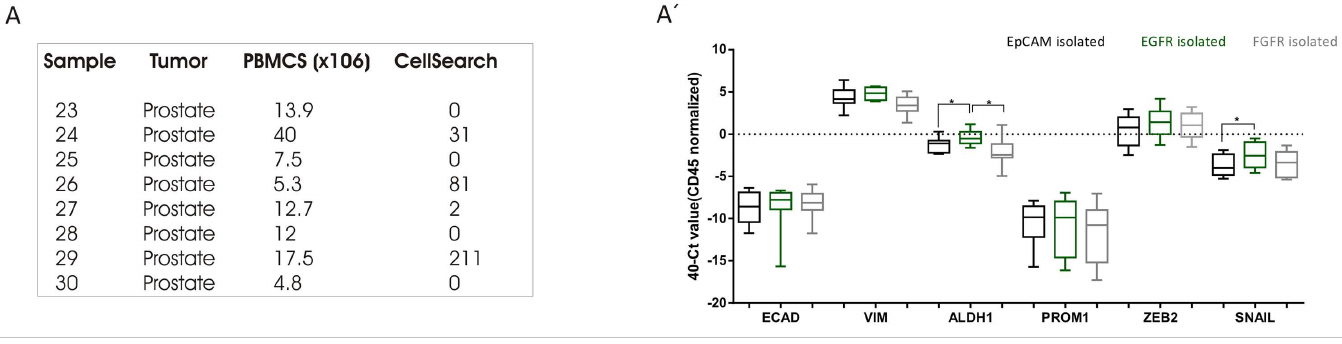
Fig 7. EGFR isolated CTCs depict differential subpopulation. Gene expression profilingof indicated genes in isolated CTCs from patients with metastatic prostate cancer using coated magnetic beads for the three fractions: EpCAM (inblack); EGFR (in green) and FGFR (in grey); (n = 8). CellSearch data regarding CTC number for each patient is summed in the box. Wilcoxon signed rank test, * p < 0.05.